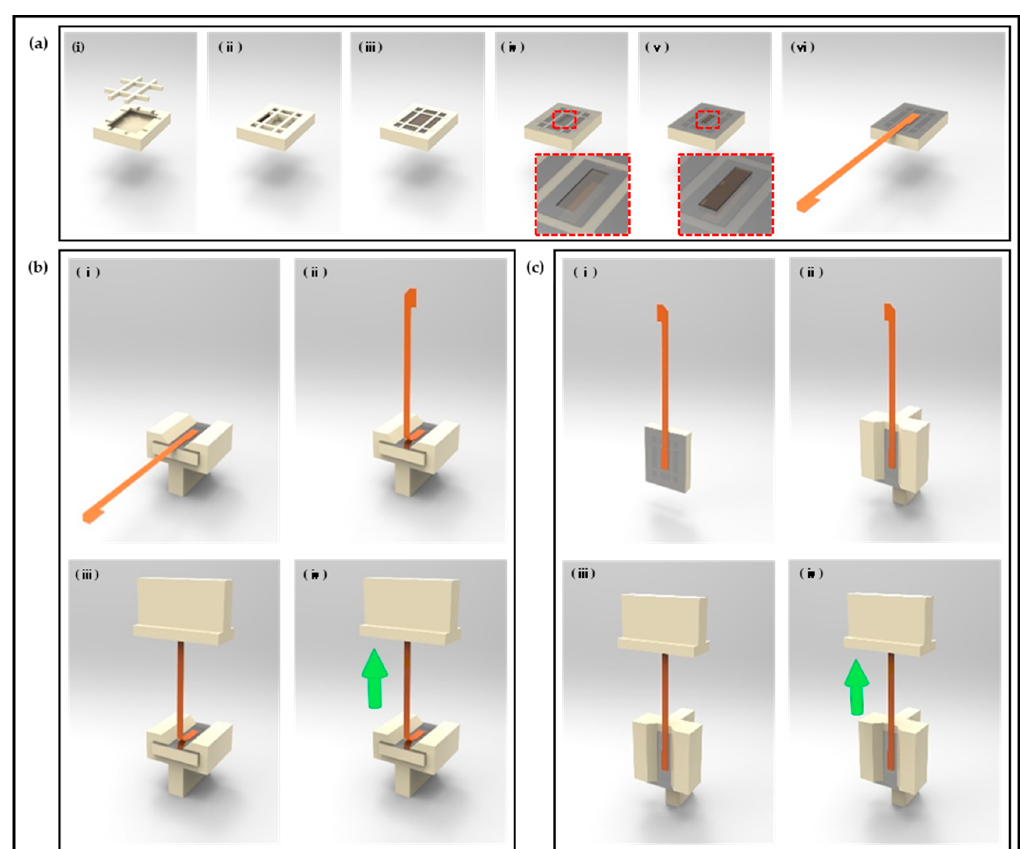
Figure 4. Procedures of adhesion evaluation test sample preparation. ( a ) Process of sample prepa- ration with uniform adhered area between epoxy and FPBC; ( a- ⅰ – a- ⅱ ) preparation and assembly of 3D-printed sample holder; ( a- ⅲ ) filling and curing epoxy into vacancy of sample holder; ( a- ⅳ ) cov- ering epoxy surface with detachable tape excluding uniform area; ( a- ⅴ ) additional epoxy filling and squeezing epoxy into uncovered area; and ( a- ⅵ ) applying FPCB to uncured epoxy and curing. ( b ) Tear-test procedures. ( c ) Shear-test procedures.